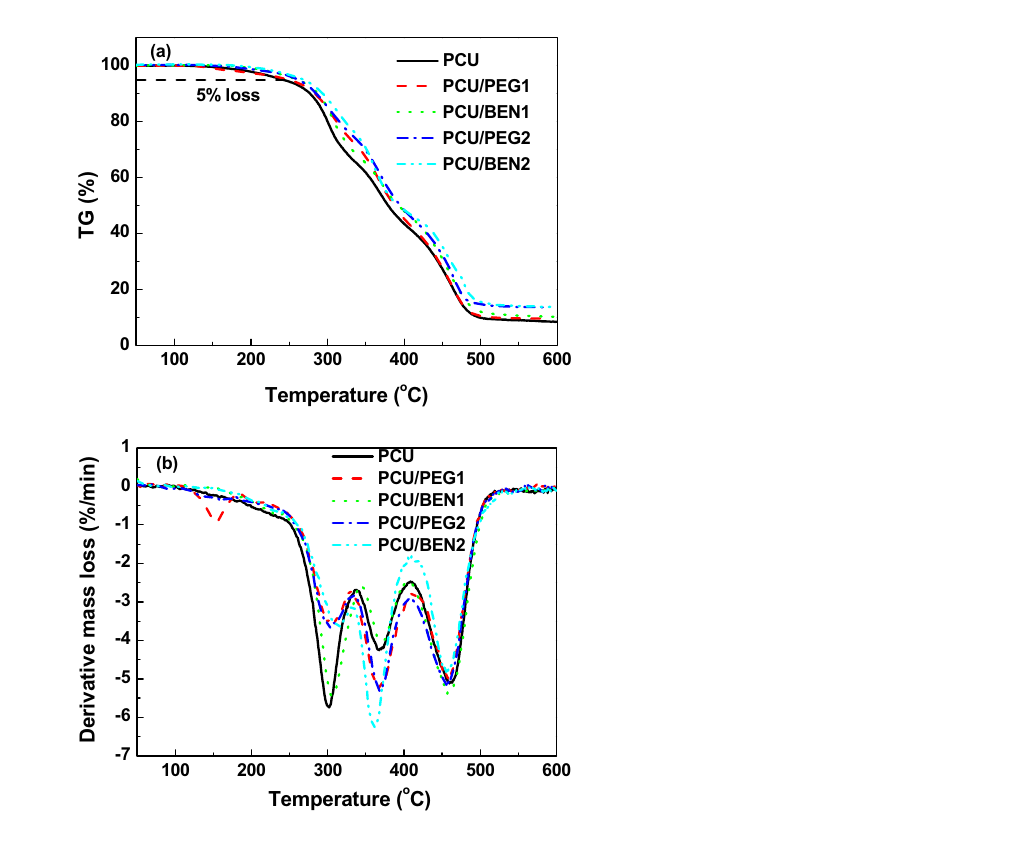
Figure 4. TG ( a ) and DTG ( b ) curves of